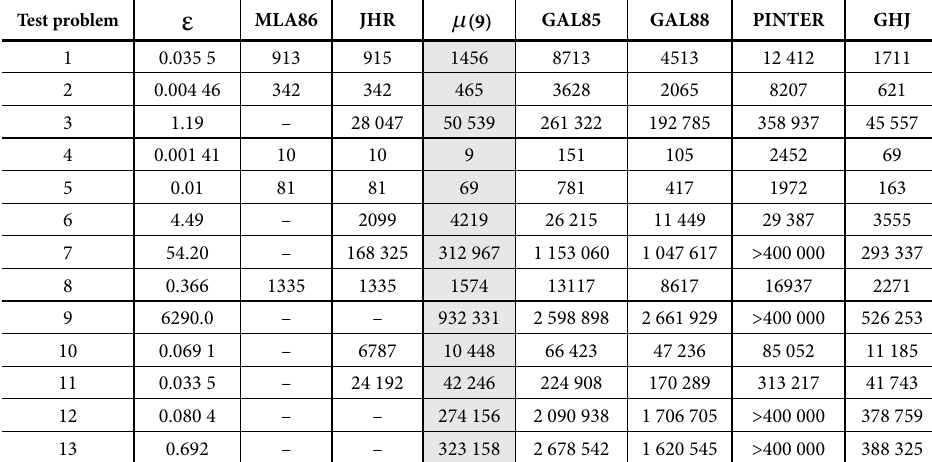
Table 3. The numbers of function evaluations for n = 2 with higher precision ε Test problem